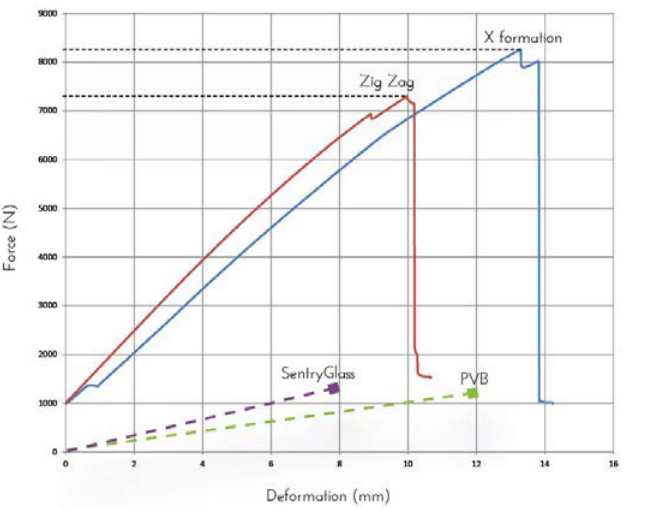
Fig. 14: Results of the bending tests